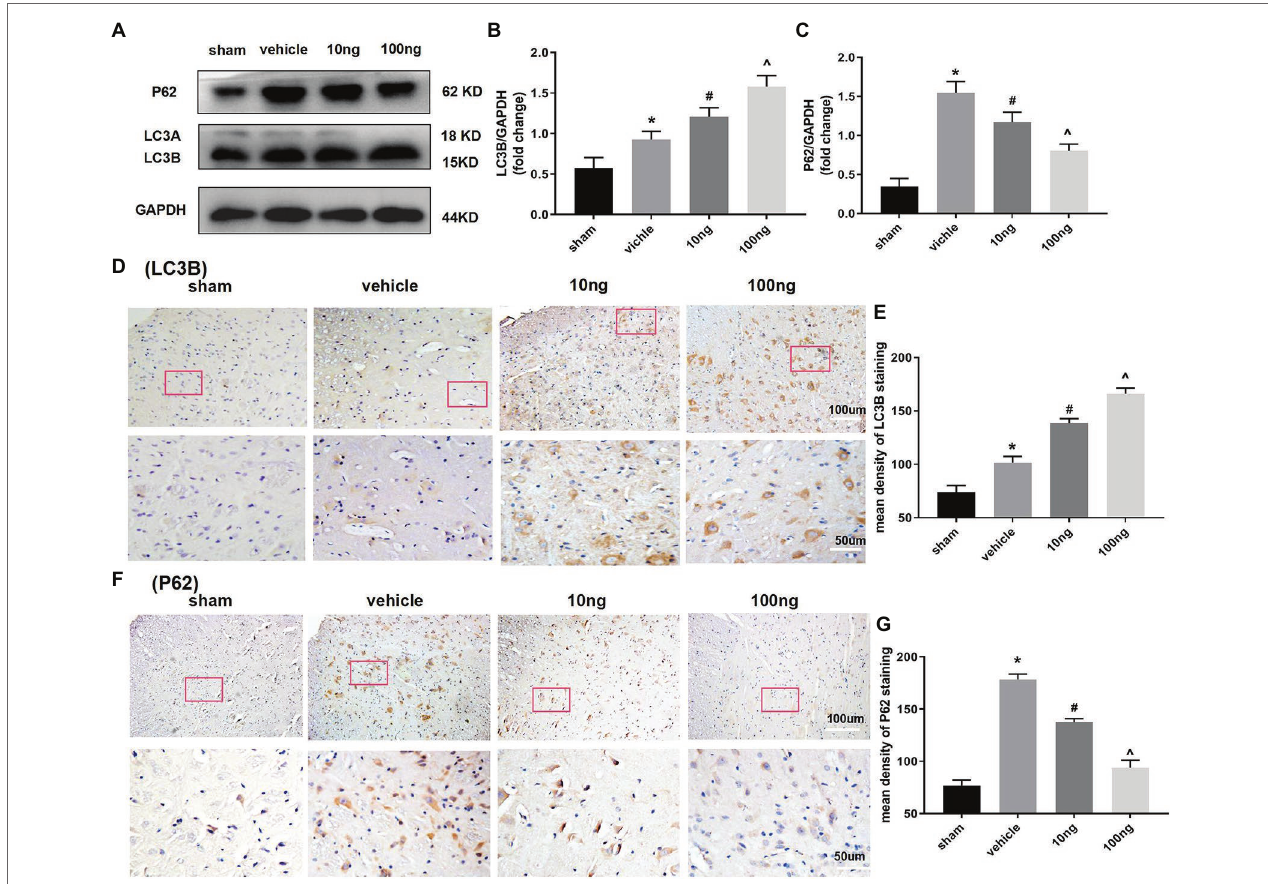
FIGURE 3 | Protectin DX dose-dependently facilitated autophagy flux in spinal cord horns ( n = 3/group). Western blot (A) and immunohistochemistry (D,F) were respectively conducted to determine the protein levels of expression of LC3B and p62. The intrathecal treatment of PDX could dose-dependently boost protein levels of LC3B and inhibit protein expression of P62. Statistical analysis of LC3B (B,E) and p62 (C,G) . One-way ANOVA was used for comparisons among groups followed by Turkey’s multiple comparisons test; Values are displayed as mean ± SEM (* p < 0.05 vs. sham group; # p < 0.05 vs. vehicle group; ^ p < 0.05 vs. 10 ng